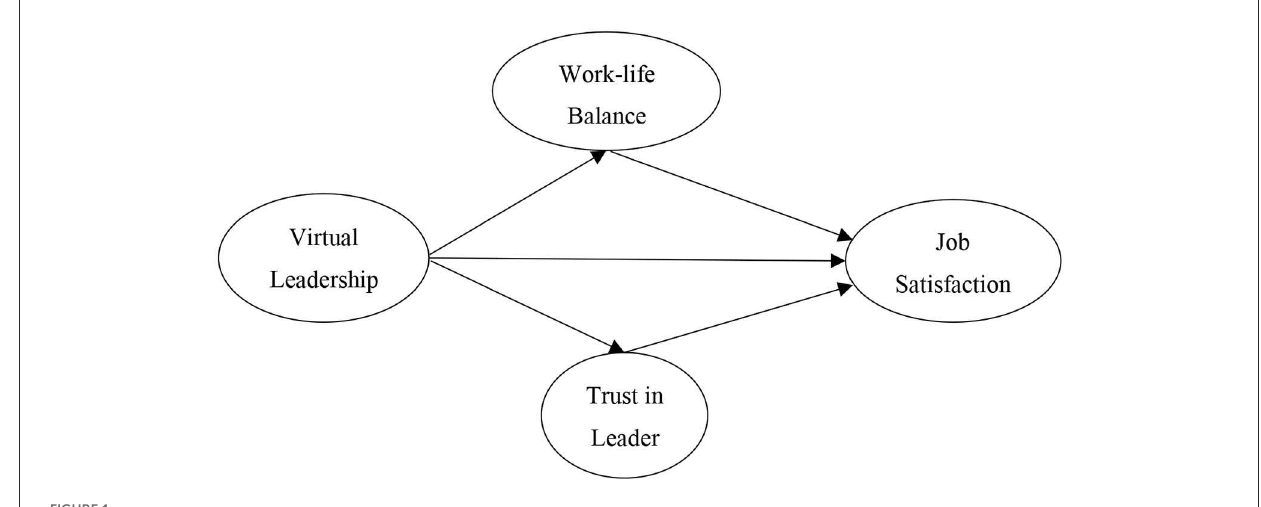
FIGURE1 Theoretical